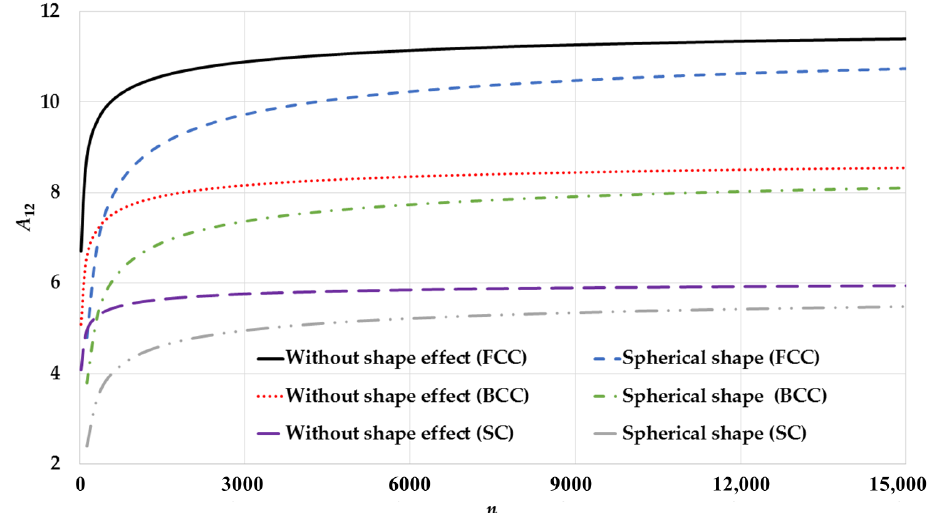
Figure 2. Size-dependent of the potential parameter 𝐴 12 as function of 𝑛 of spherical nanoparticles in different cubic structures: SC, BCC, and FCC and compared to without shape effect case that is based on Qi et al. model [34].